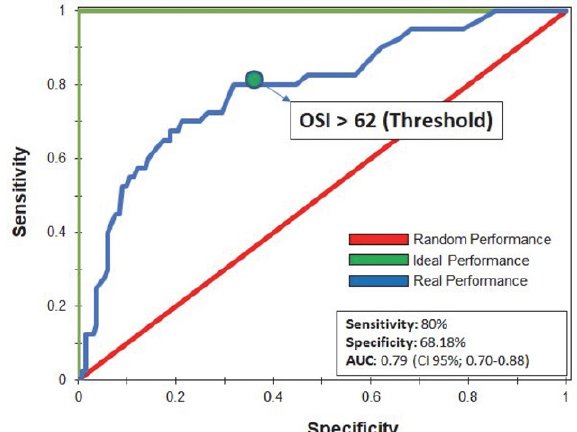
Figure 3: ROC curve for predicting ICU admission for COVID-19 positive patients. * OSI - index of oxidative stress AUC - area under the ROC